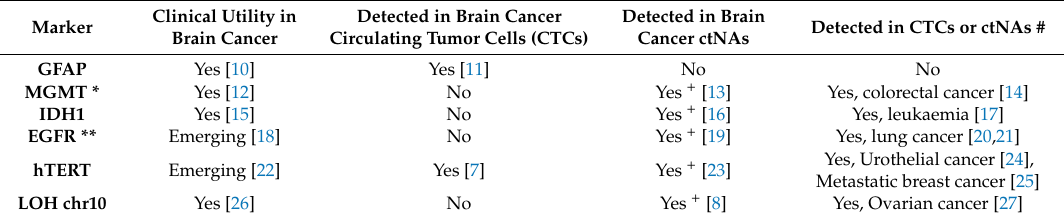
Table 1. Brain cancer biomarkers and detection in liquid